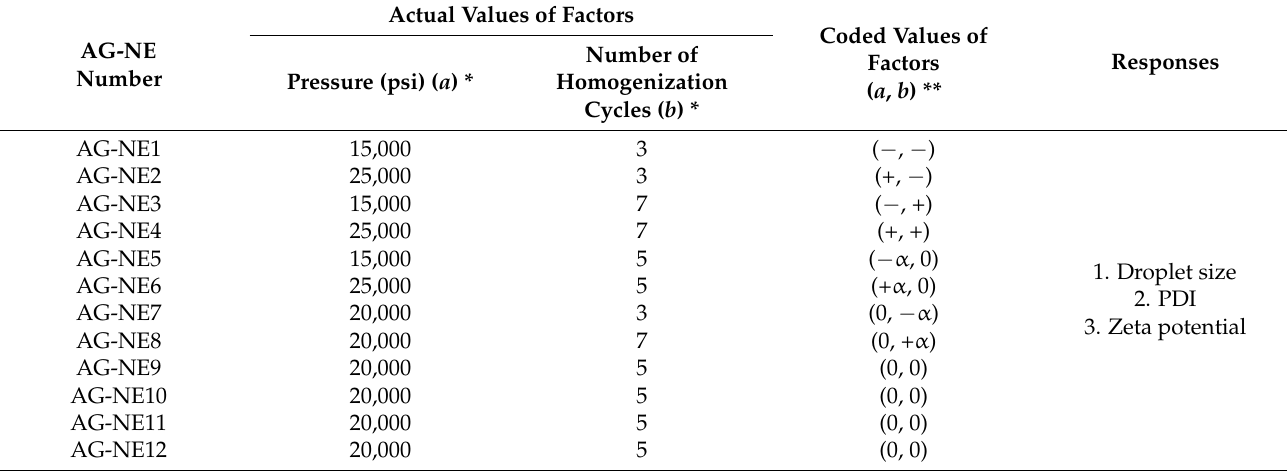
Table 1. Actual values and coded values of factors and responses for the